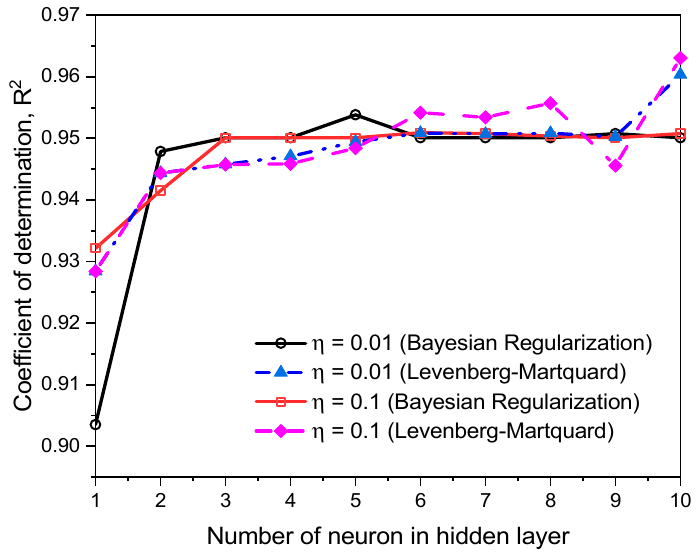
Figure 8. Relationship between R 2 value and number of neurons in the hidden layer according to learning rate for Bayesian Regularization and Levenberg Marquardt.